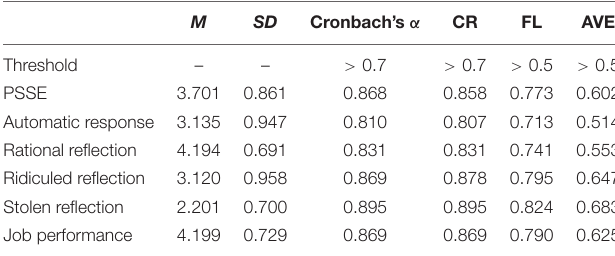
TABLE 2 | Construct reliability and